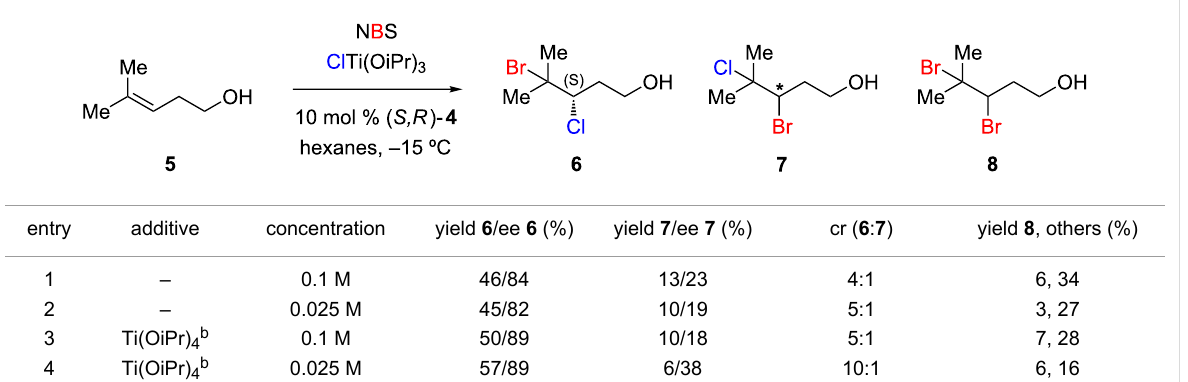
Table 1: Optimization of a selective homoallylic bromochlorination reaction.